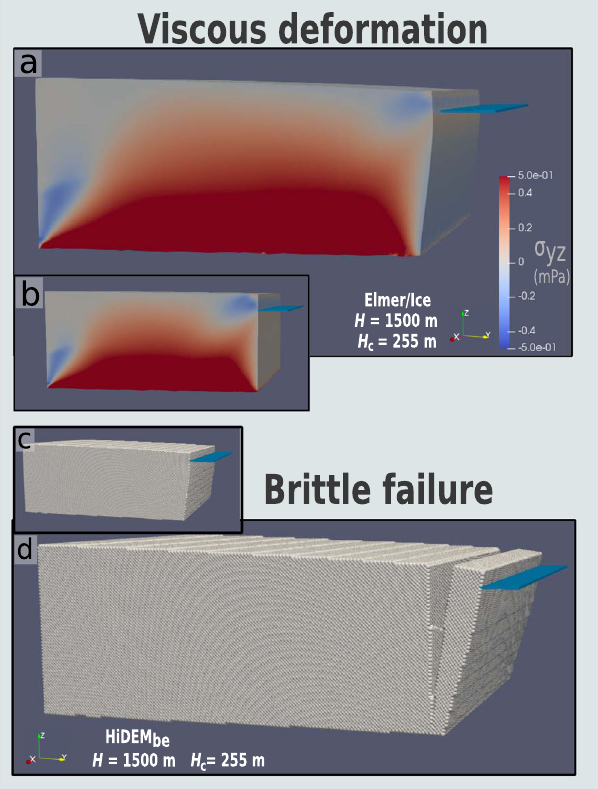
Fig. 1 Mode of structural failure in which tensile failure follows viscous deformation. a Viscous deformation of a glacier geometry as modeled in Elmer/Ice. The Cauchy shear stress tensor component aligned with fl ow direction ( σ yz ) shows a maximum at the base and waterline of the calving face. b The geometry and σ yz fi eld shown in ( a ) prior to viscous deformation. c The brittle-elastic version of the Helsinki Discrete Element Model (HiDEM be ) domain initialized with the output geometry of the Elmer/Ice simulation in a . d An example of brittle failure in HiDEM be caused by tensile stress at the glacier surface leading to surface crevassing and calving via forward block rotation. H = calving face thickness; H c = ice-cliff of varying B , as well as degree-of-buoyancy and surface slope, are discussed further in Supplementary Note 4.